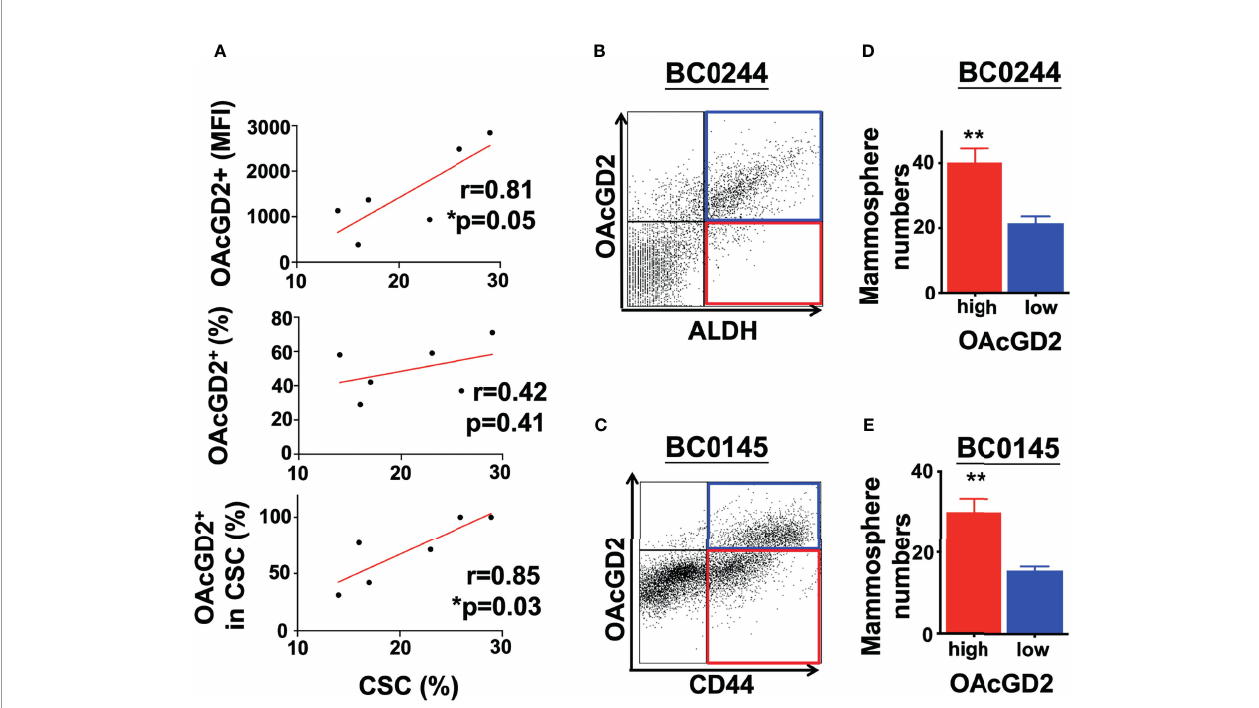
FIGURE 1 | OAcGD2-expressing breast cancer cells harvested from PDXs display enhanced mammosphere forming capacity. (A) Pearson correlation analysis between percent of CSCs population and OAcGD2 expression in PDXs as shown in . Pearson correlation coef fi cient (r) and p -value (p) were shown. (B) BC0244 cells were stained with anti-OAcGD2 antibody and ALDEFLUOR ™ kit. The OAcGD2 high ALDH + and OAcGD2 low ALDH + BC0244 cells were sorted by FACSAria II and seeded at 1 × 10 3 /well into a 96-well ultra-low attachment plate containing mammosphere growth medium to determine their mammosphere formation ability. (C) BC0145 cells were stained with anti-OAcGD2, anti-CD44-APC, and anti-CD24-FITC. OAcGD2 high CD44 + CD24 − and OAcGD2 low CD44 + CD24 − BC0145 cells were sorted to examine their mammosphere formation ability. (D, E) Seven days after culture, the number of mammosphere was counted under a bright- fi eld microscope. The results were presented as mean ± SD of the mammosphere numbers. Data were analyzed by Pearson correlation analysis and Student ’ s t-test. * p < 0.05, ** p < 0.01.